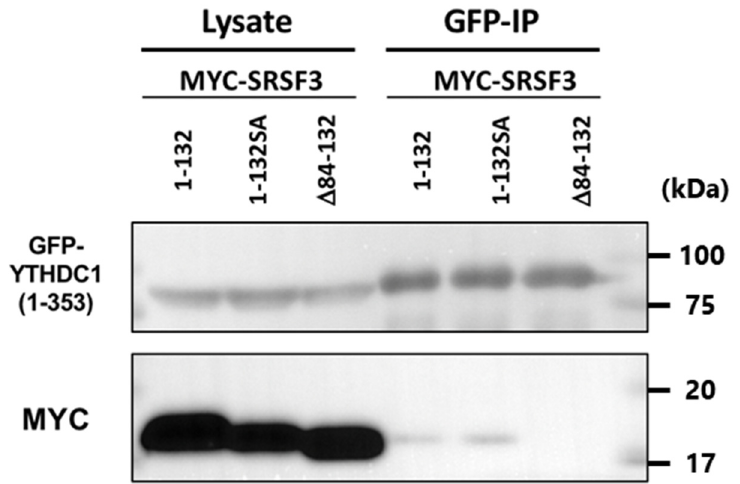
Figure 7. HeLa cells were co-transfected with GFP-YTHDC1(1–353), Myc-SRSF3, or Myc-SRSF3 deletion mutants. The lysates of co-transfected cells were immunoprecipitated using anti-GFP antibody. Lysates and IP samples were detected by western blotting using anti-GFP or anti-Myc antibodies.